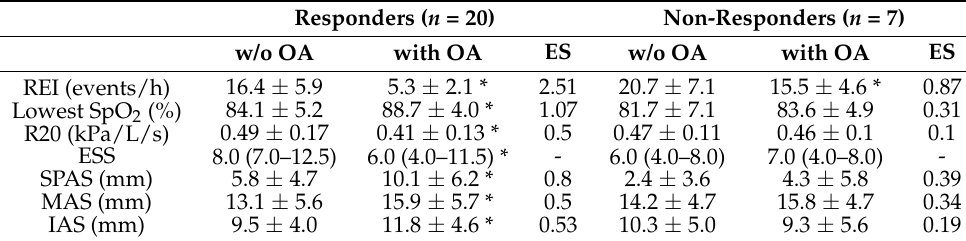
Table 2. Efficacy of oral appliance therapy in the responders and the